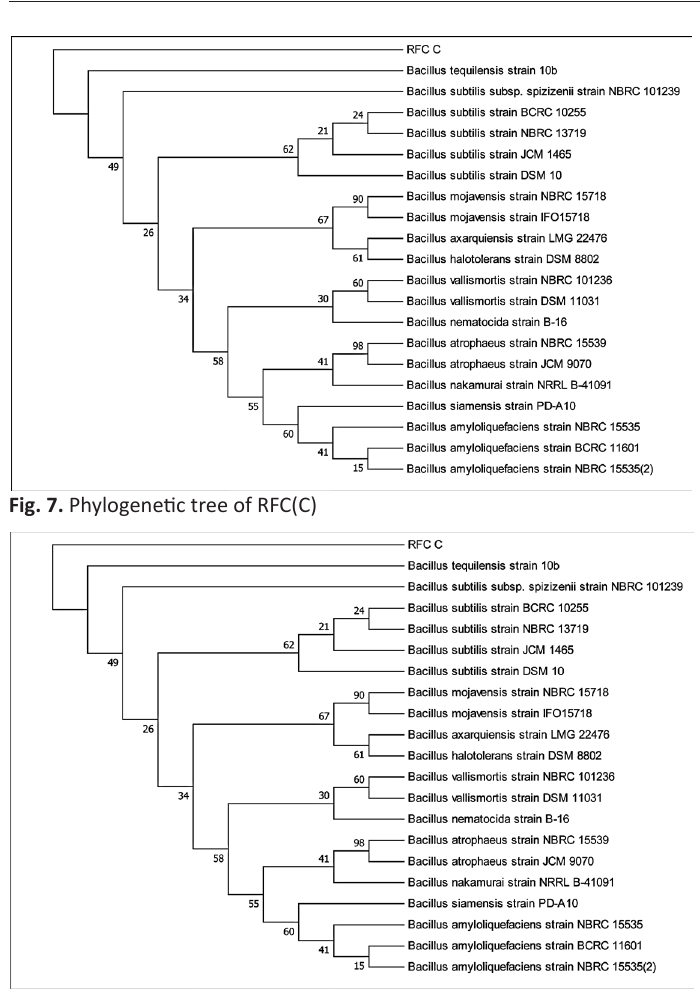
Fig. 8. Phylogenetic tree of RFC(W)